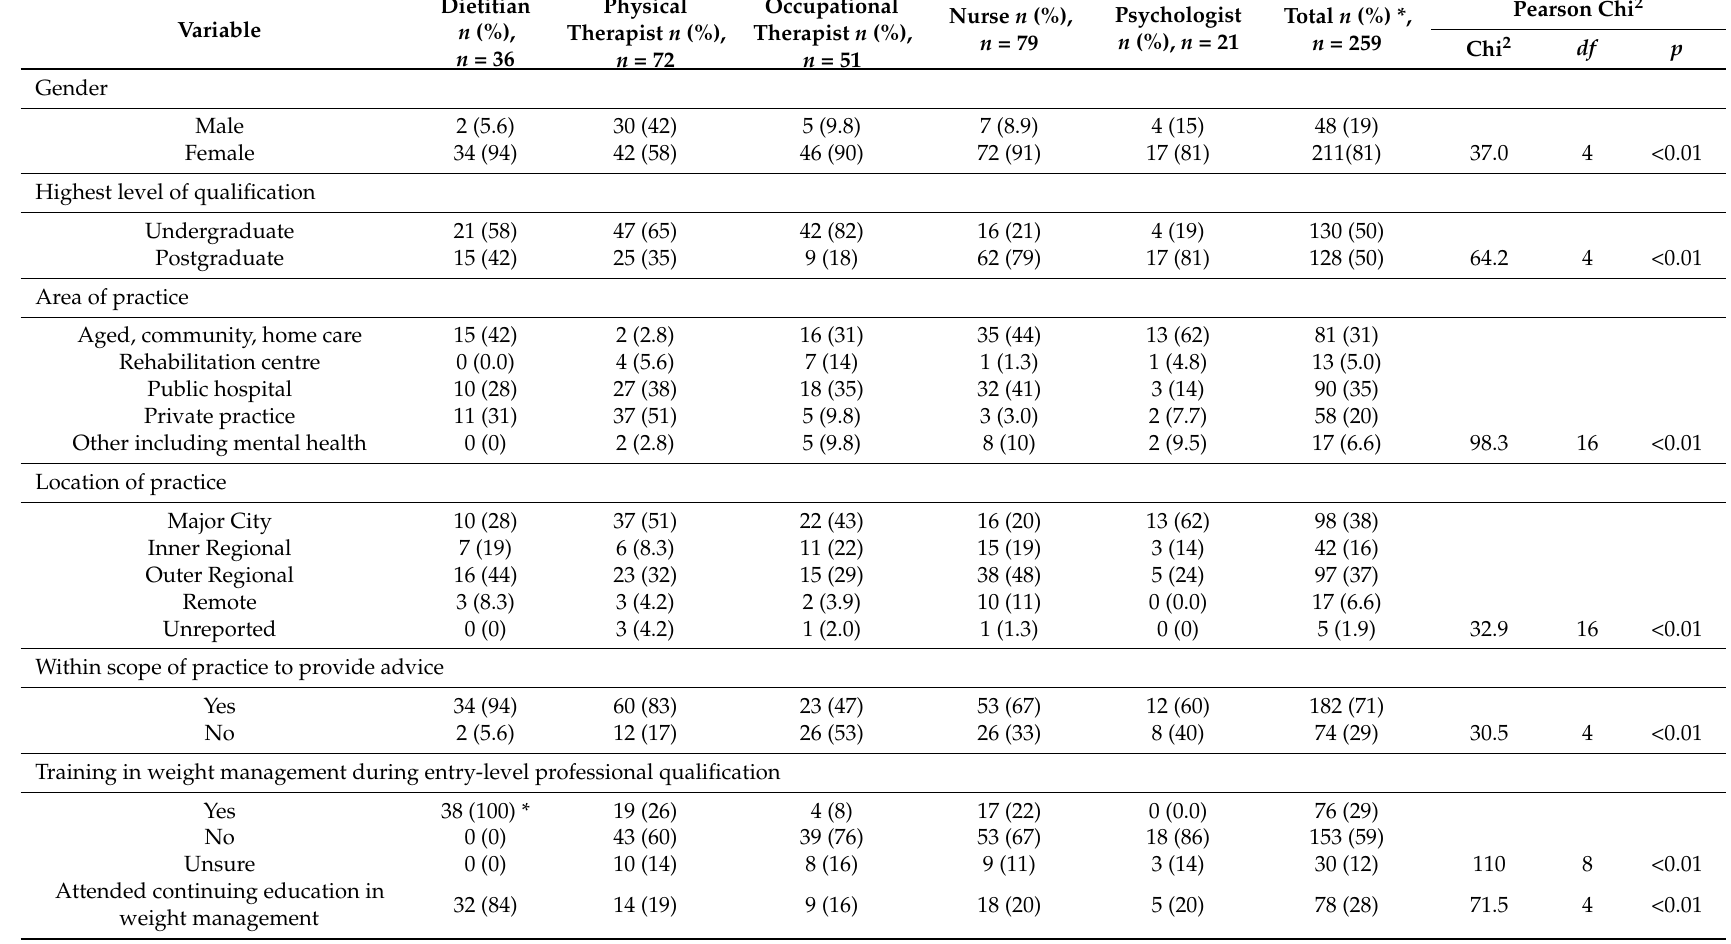
Table 2. Demographics of allied health professionals ( n = 296) participating in